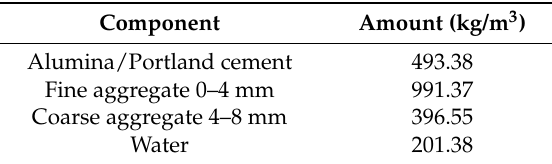
Table 5. The concretes’ mix proportions.